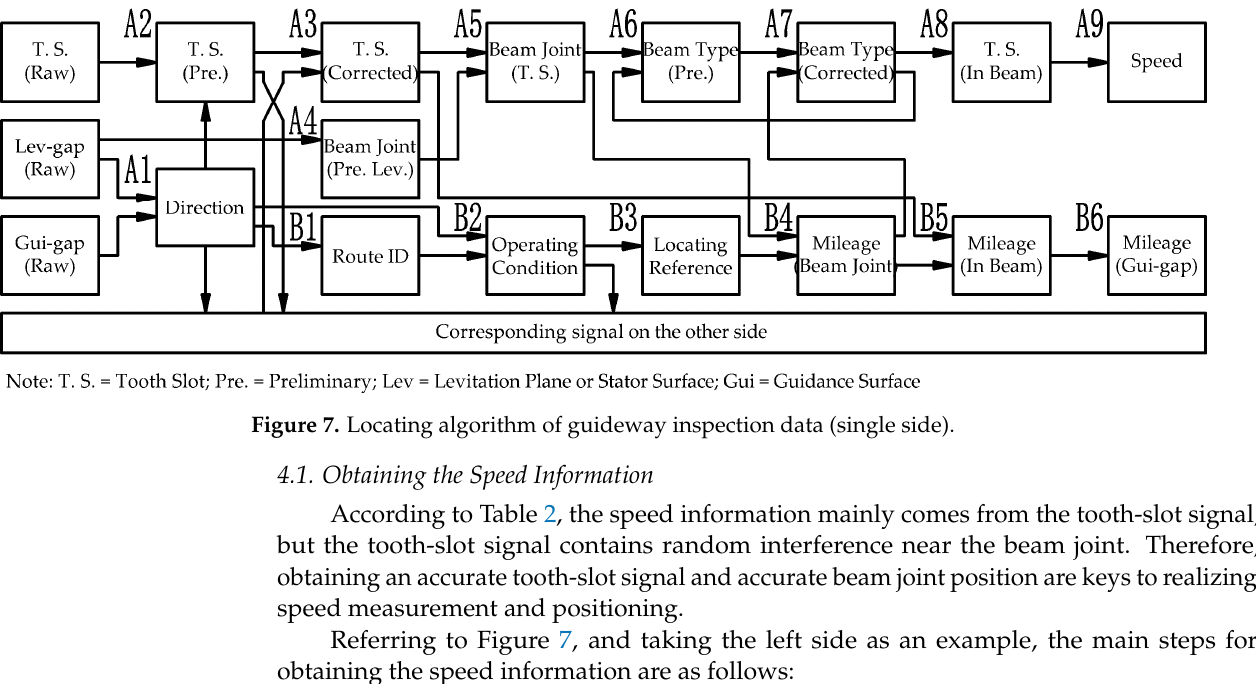
Figure 6. Schematic diagram of locating principle.